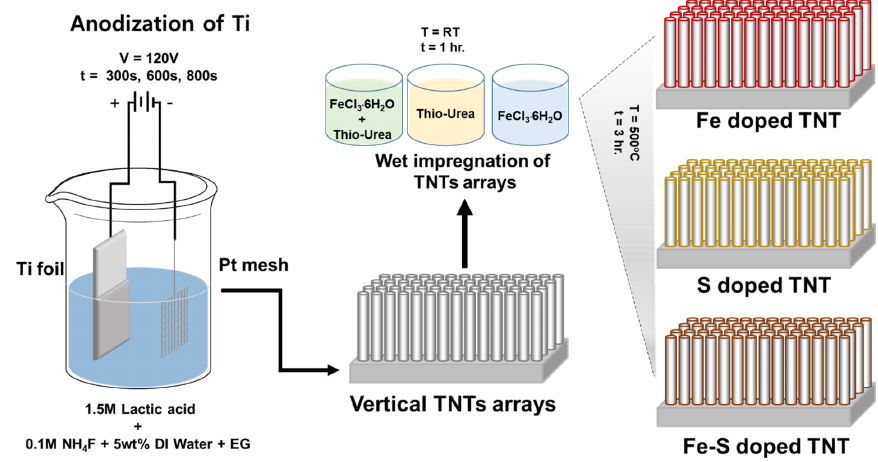
Figure 1. A schematic illustration of the preparation steps for Fe, S, and Fe-S doped